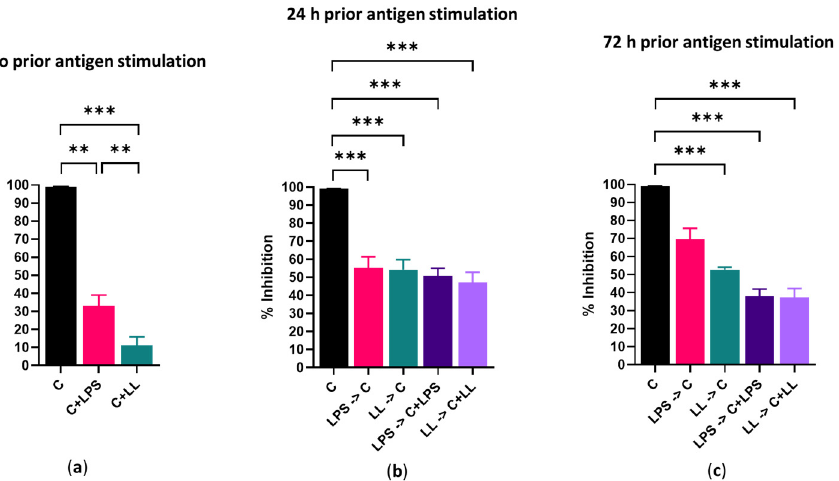
Figure 4. Effect of 150 µM/mL capsaicin on Cal 27 cell metabolism. Cal 27 cells were either with ( a ) no antigen pre-stimulation or ( b ) 24 h or ( c ) 72 h bacterial antigens pre-stimulation prior to the addition of inhibitory drugs. C = capsaicin, LPS = lipopolysaccharide, LL = LPS + LTA (lipoteichoic acid). Letter before the arrow represents pre-stimulation, e.g., LPS -> C is LPS pre-stimulation and then treatment with capsaicin (C). n = 9 biological replicates. Error bars represent standard error of the mean. ** p < 0.01, *** p <